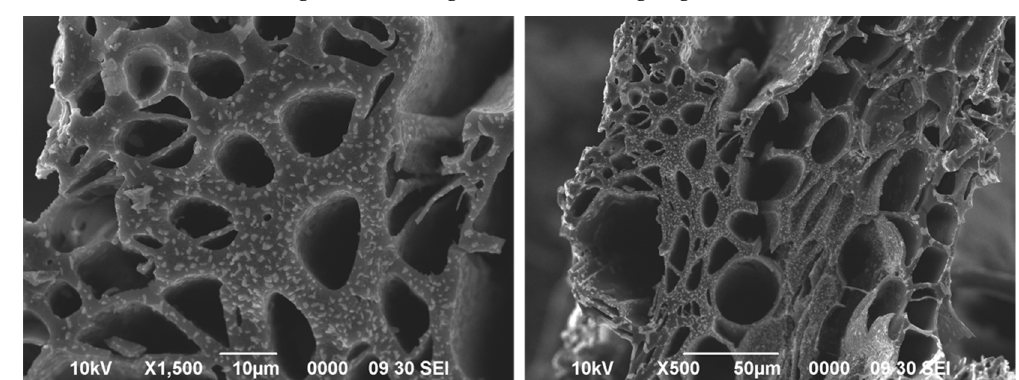
Figure 2. Scanning electron micrographs of charcoal at 1500× and 500× magnifications.